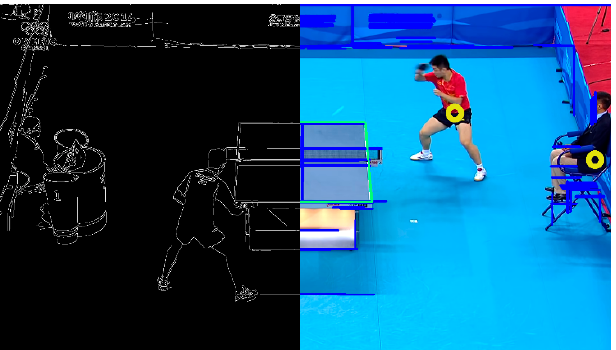
Figure 1. The transformation to edges for the Hough transform on the left side and detection of player and table position on the right side.